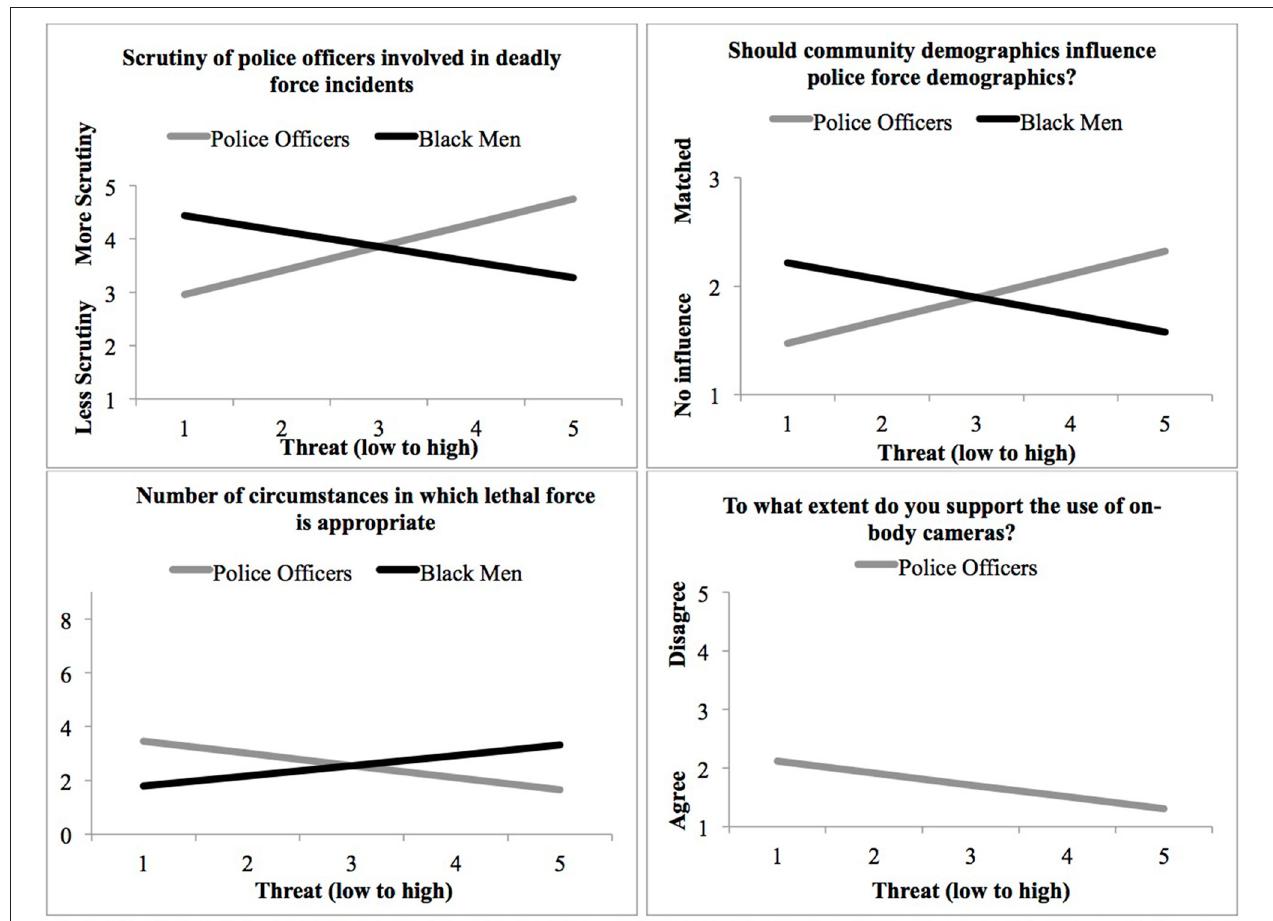
FIGURE 1 | Panels depict the significant relationships between threat associated with police officers and Black men and each of the four policy outcome measures from Study